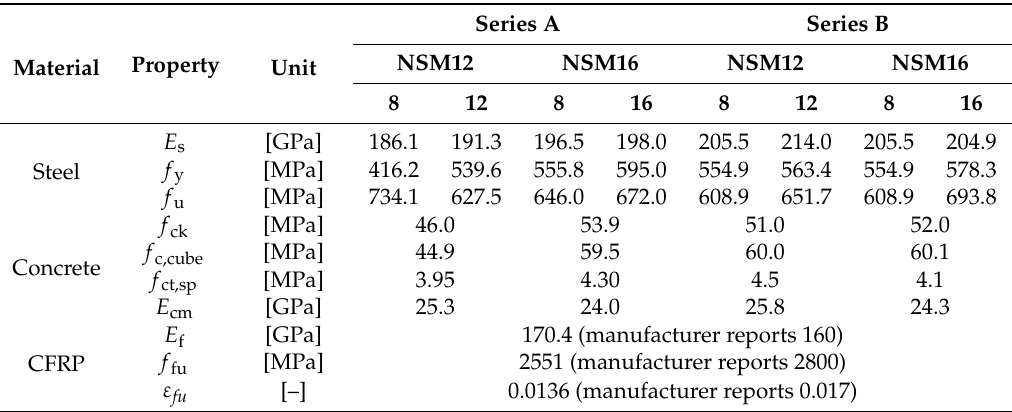
Table 2. Strength characteristics of used